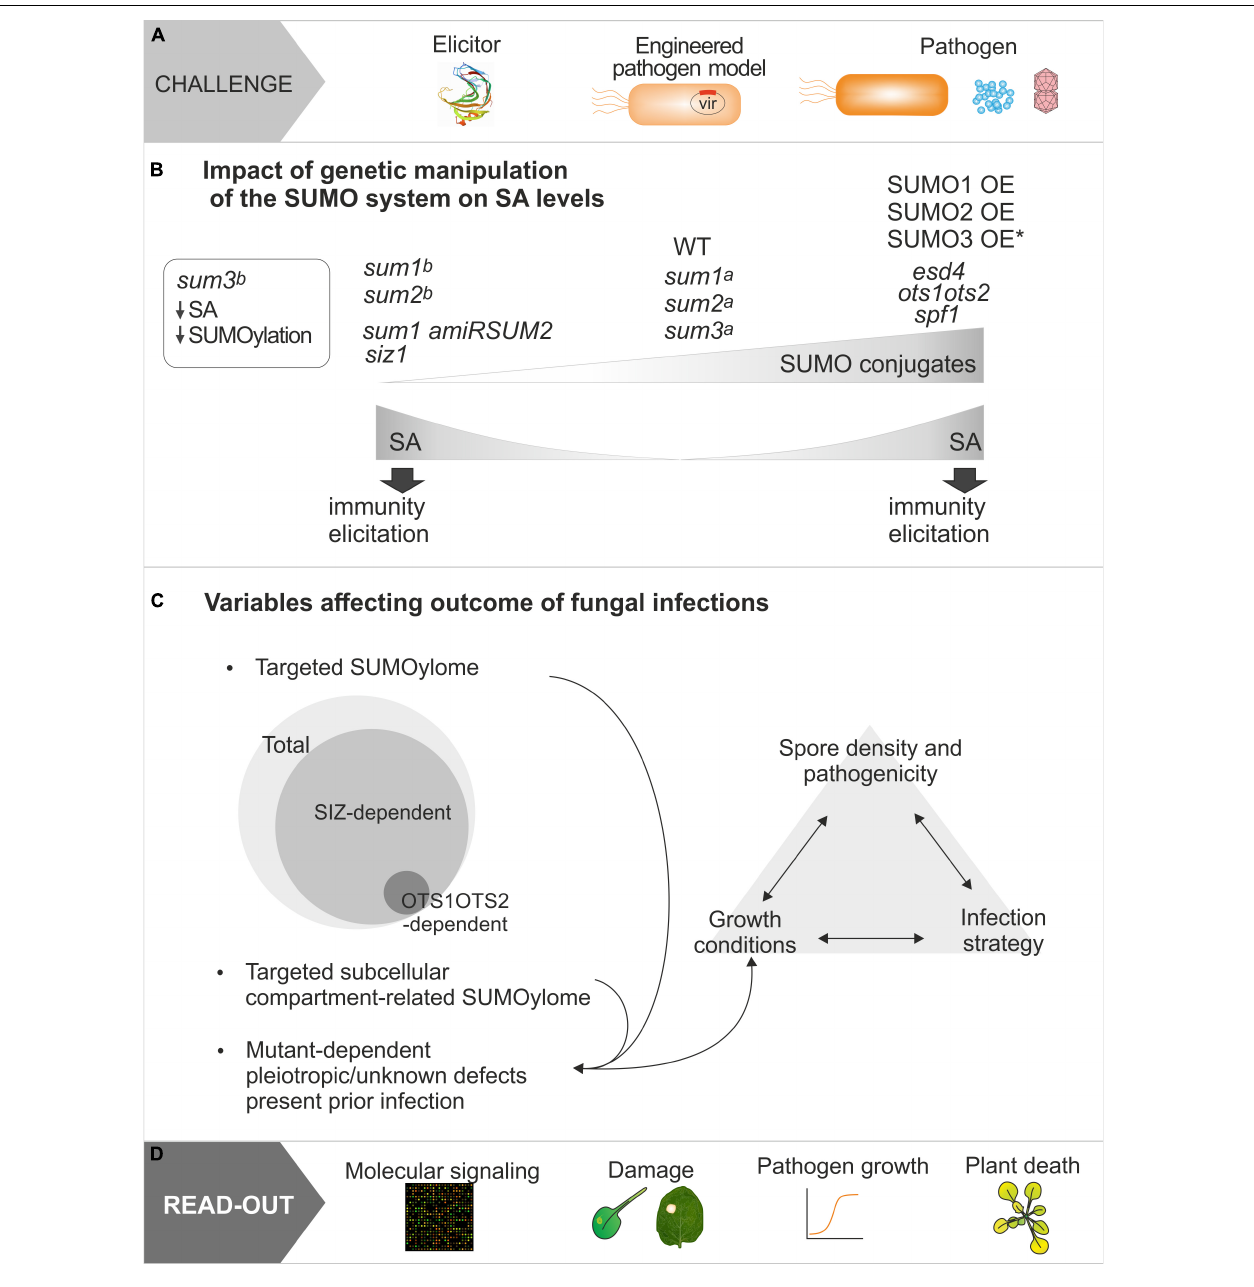
FIGURE 2 | Multifactorial aspects affecting the study of the regulation of plant defense responses by SUMO conjugation. (A) Representation of approaches used to study plant defenses responses, which include molecule elicitation, pathogen model expressing a virulence effector from the pathogen of interest, or the pathogen of interest (bacteria, fungi, and viruses). (B) Different genetic manipulations leading to increase or decrease plant SUMO conjugation converge in salicylic acid accumulation and plant immunity elicitation. WT refers to levels in wild type plants. Mutated components of the SUMOylation machinery are indicated in italics. Single SUMO mutant plants (sum1, sum2, and sum3) have been reported not show [a, (van den Burg et al., 2010)], and to show [b, (Ingole et al., 2021b)] alterations in SA levels. (C) Summary of distinct experimental approaches used in studies analyzing the role of SUMOylation in defense against fungal pathogens and that may lead to the controversial conclusions generated. (D) Type of read-outs used in the studies